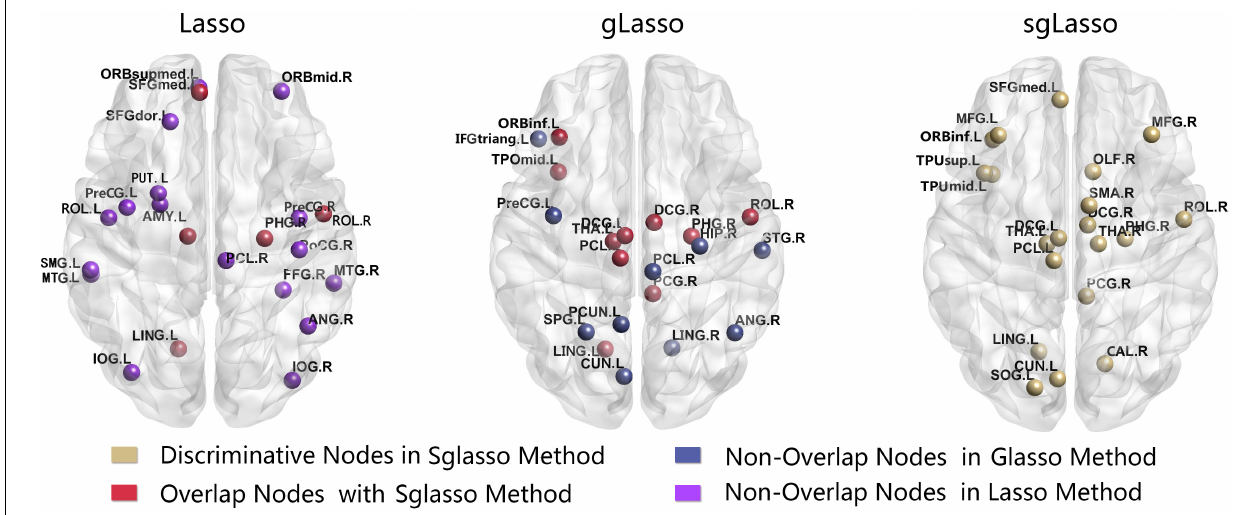
FIGURE 8 | All abnormal brain regions were mapped onto the cortical surfaces using BrainNet viewer